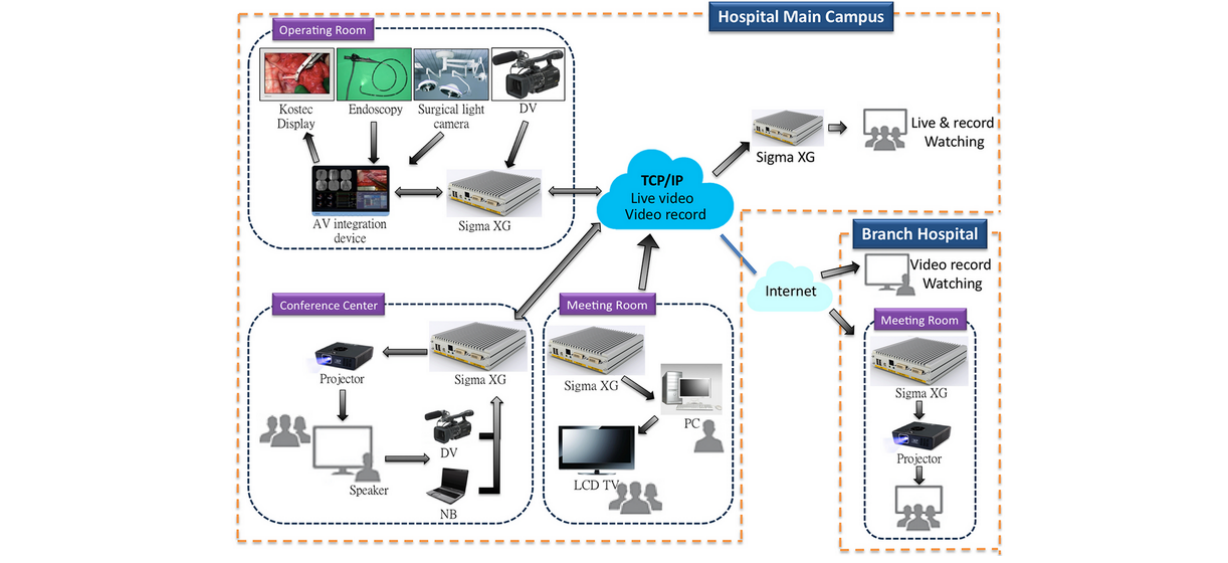
Figure 7. Concept map of the intelligent operating room system. AV: audiovisual; DV: digital video; LCD: liquid-crystal display; NB: notebook; TCP/IP: transmission control protocol/internet